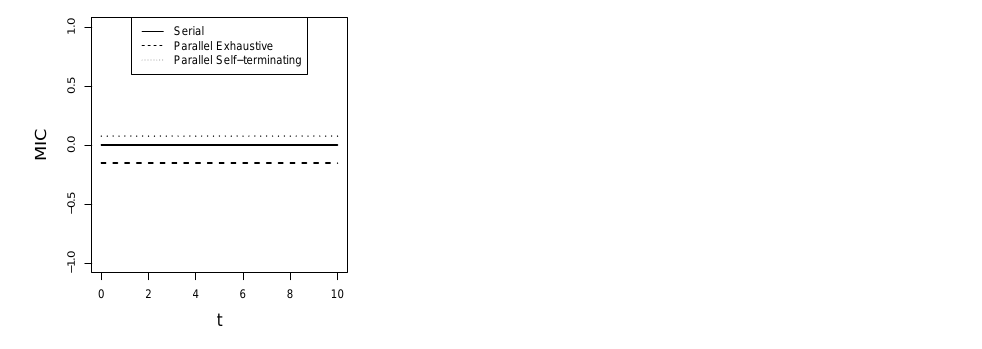
Figure 3. MIC for serial systems, parallel exhaustive systems and parallel self-terminating system.